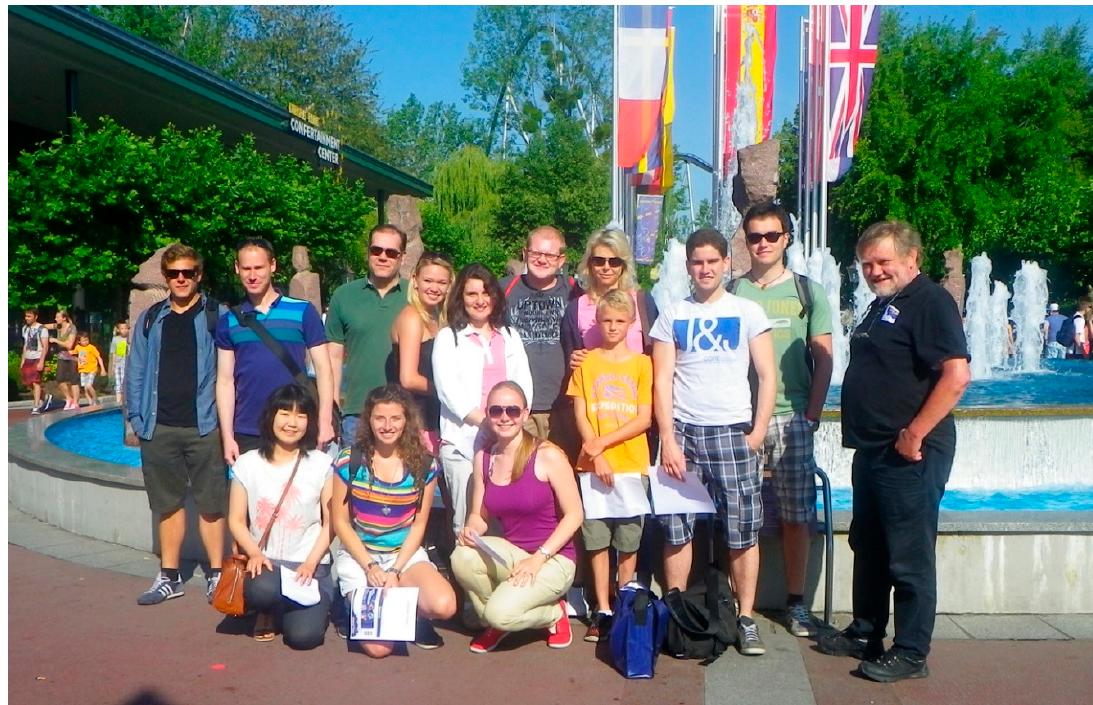
Figure 2. Ton stands to one side and lets the students take centre stage.